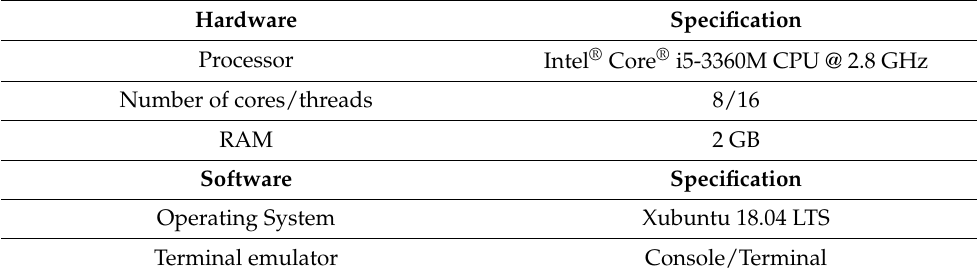
Table 1. Hardware and software specifications of the computer used in this